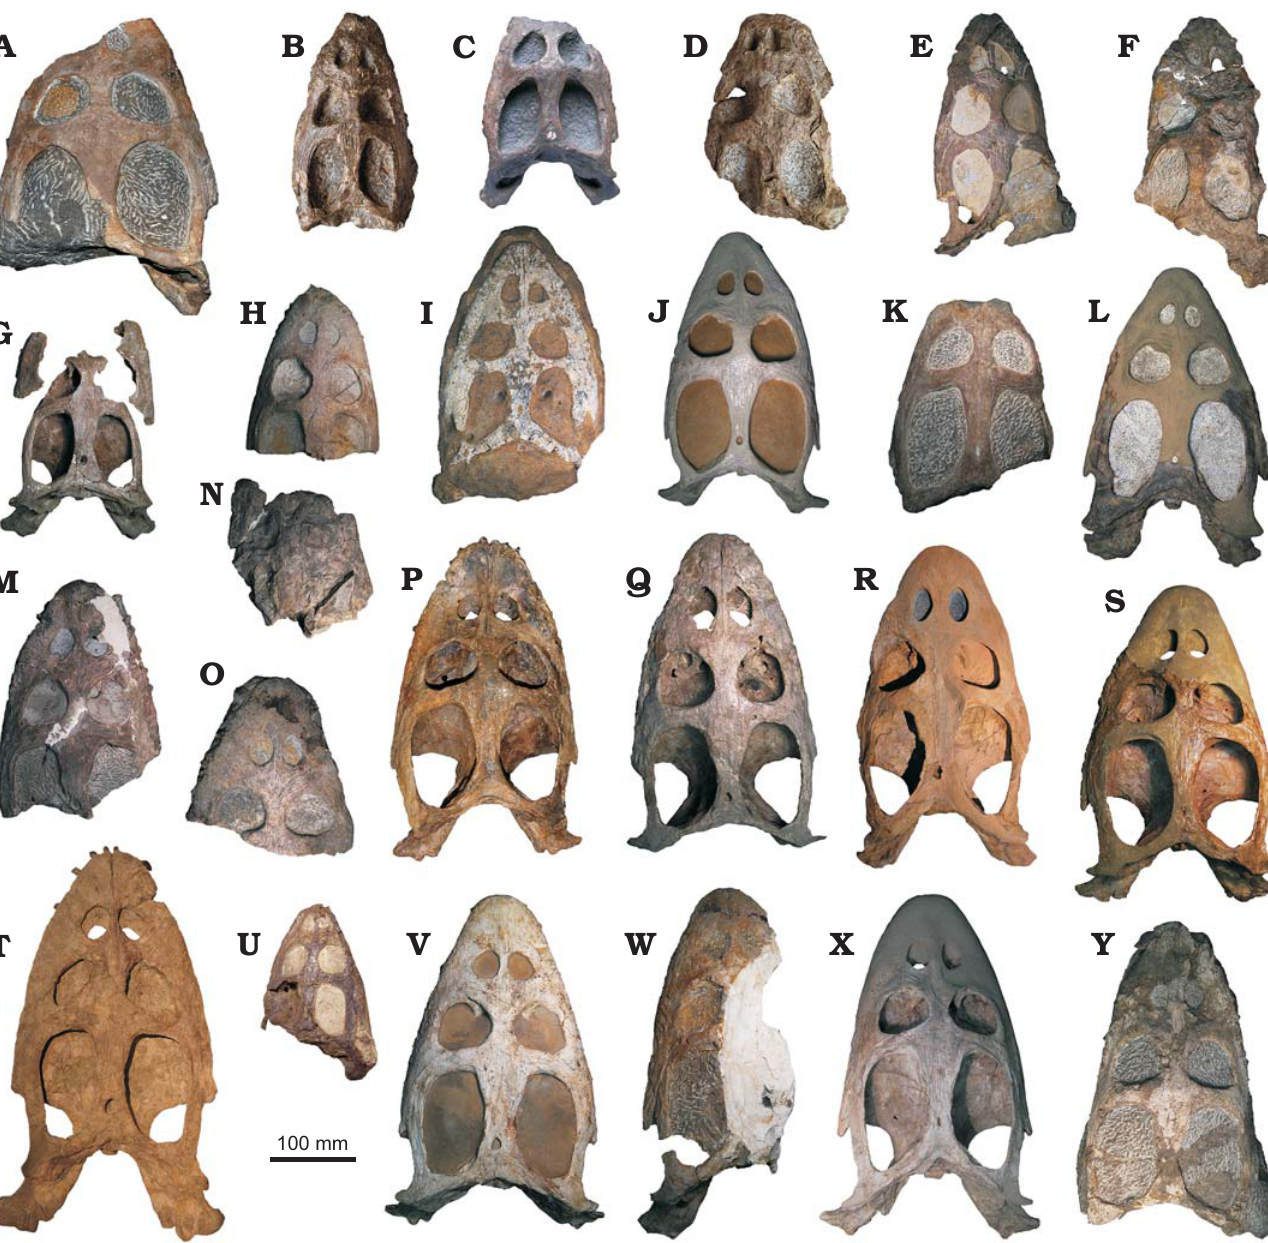
Fig. 1. Skulls of simosaurid sauropterygian Simosaurus gaillardoti Meyer, 1842 from the Ladinian, Middle Triassic of southwestern Germany (A, E–Y) and northeastern France (B–D) in dorsal view. A . MB.R. 52. B . MNHN.F.AC. 9028 (neotype of Simosaurus gaillardoti ). C . MNHN.F.AC. 9026